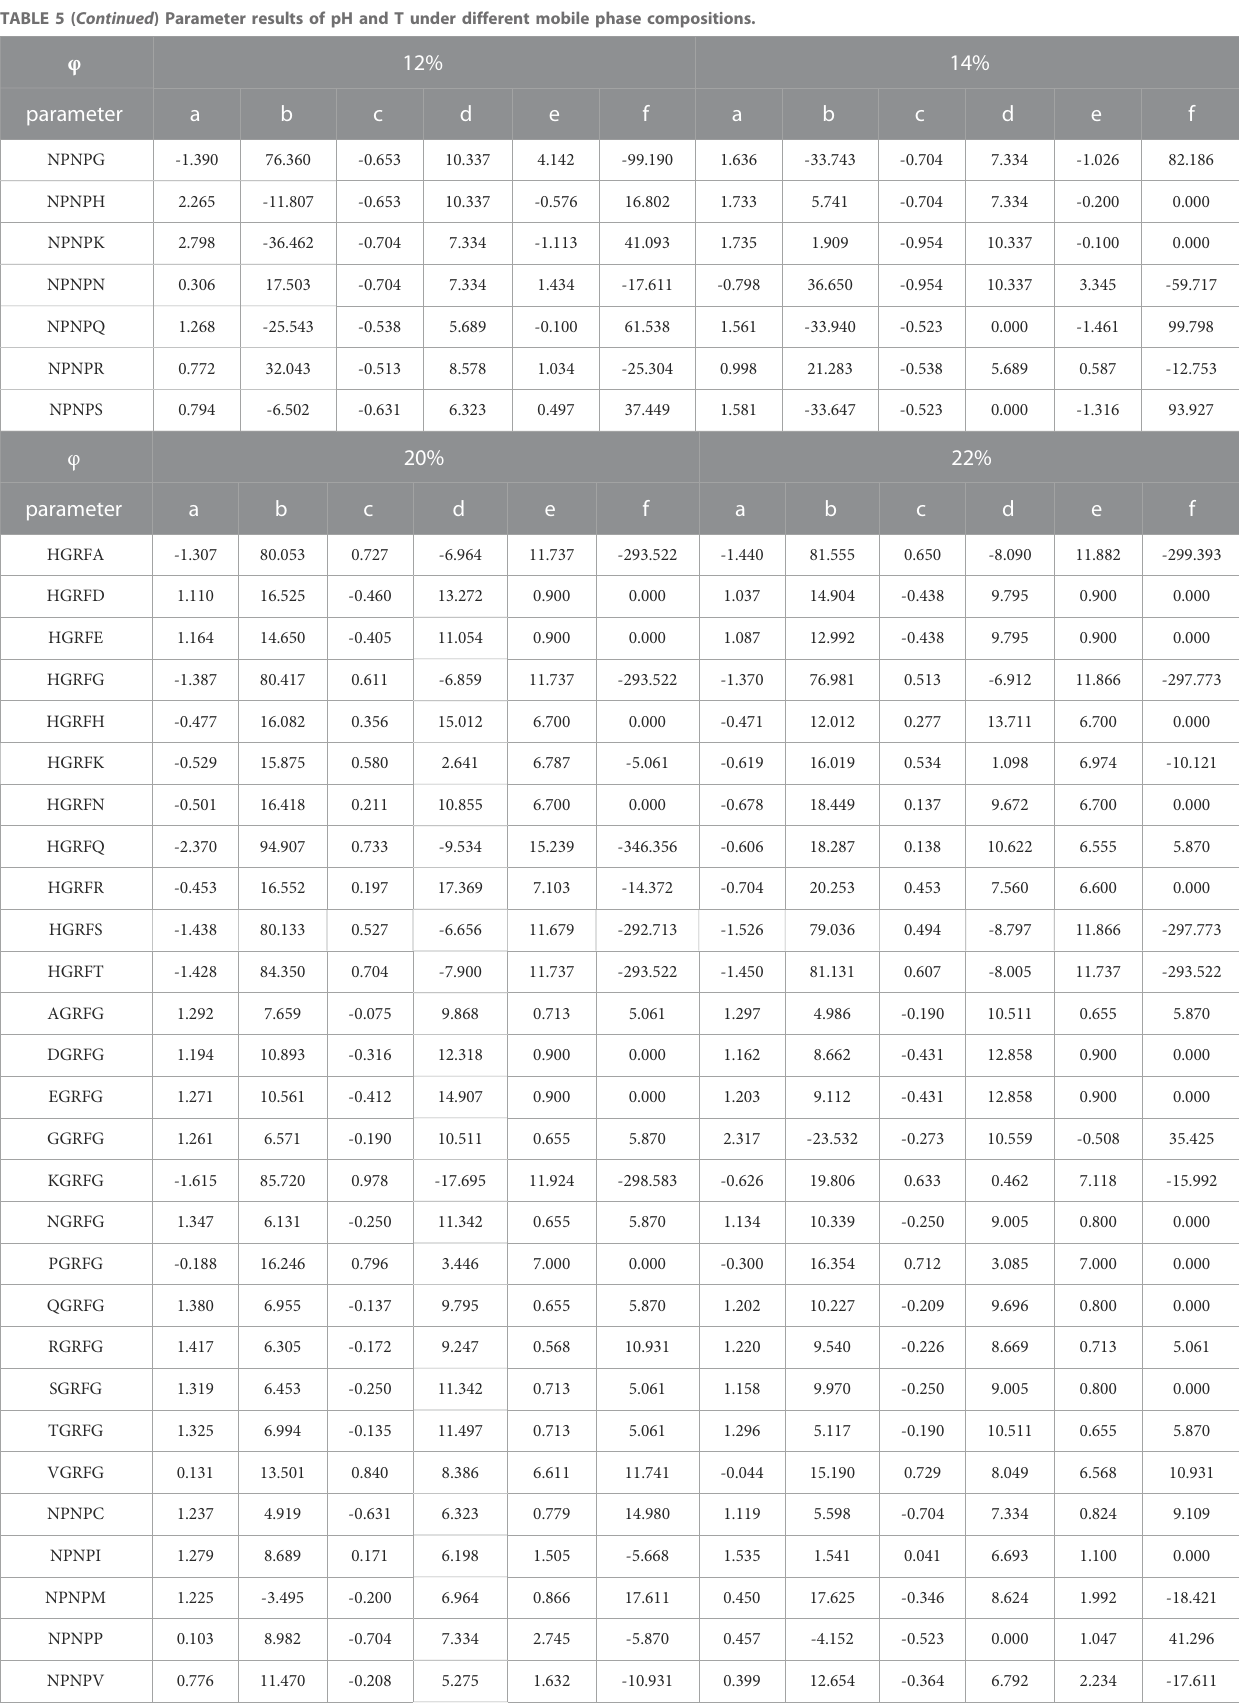
TABLE 5 ( Continued ) Parameter results of pH and T under different mobile phase